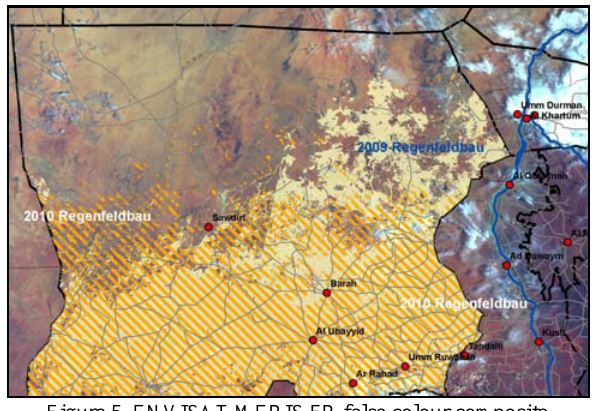
Figure 5 ENVISAT MERIS FR false colour composite (2010-09-12 – bands 13-5-1) overlaid with MERIS FR level 2 fAPAR data from 2009 versus